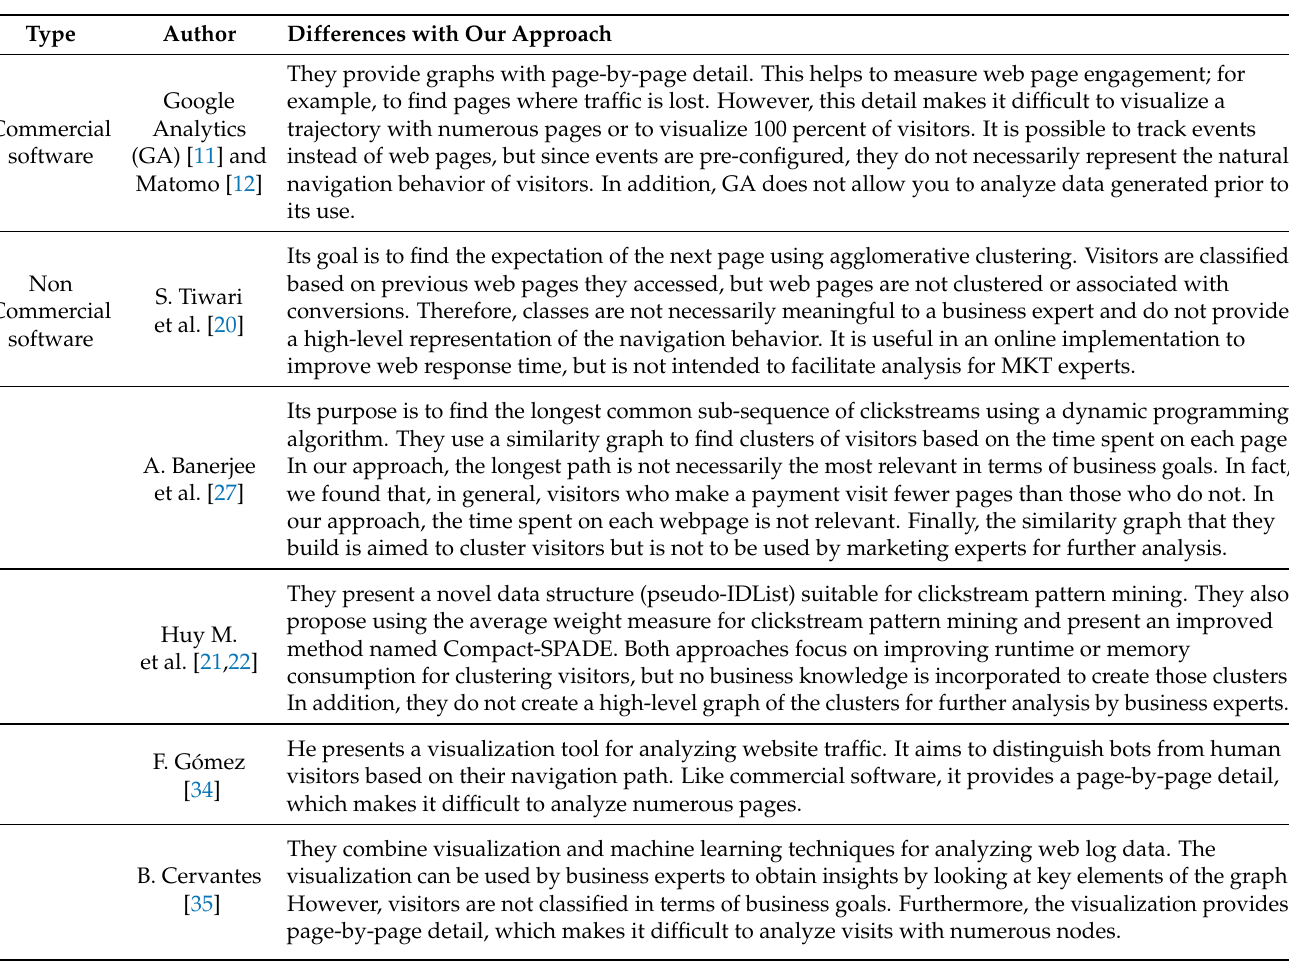
Table 8. Differences between our method and previous